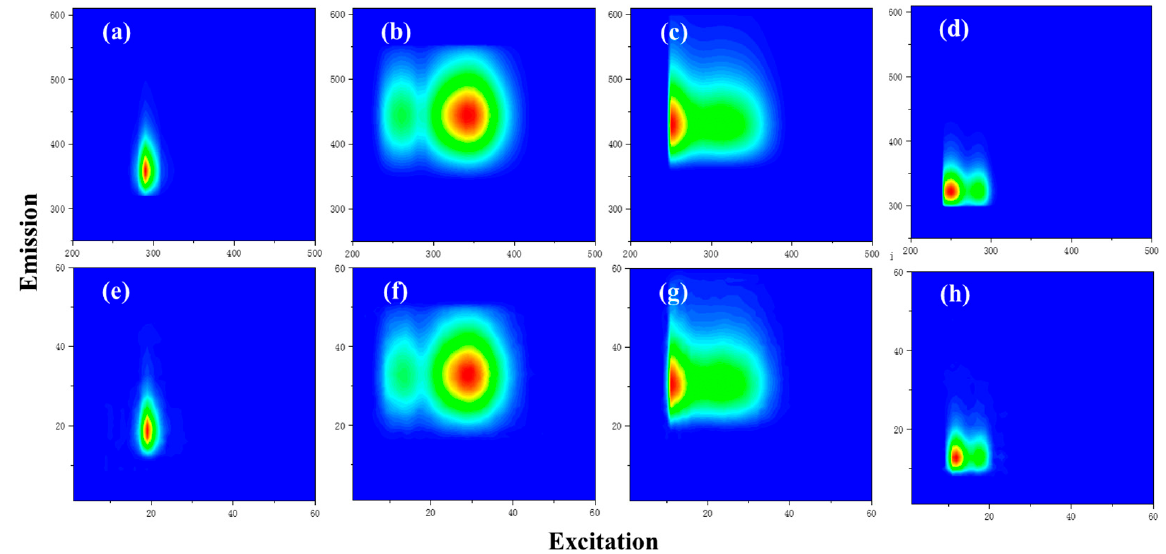
Figure 12. ( a – d ) are the first component maps of 4 types of 3D-EEMs analyzed by PARAFAC (other component maps are not listed due to limited space), ( e – h ) are the component maps obtained by CF-VGG11 fitting. In ( a – d ), the abscissa is the excitation wavelength, the ordinate is the emission wavelength, and the fluorescence intensity is the fluorescence intensity after Raman normalization. In ( e – h ), the abscissa = (excitation-200)/5 and the ordinate is (emission-250)/6.